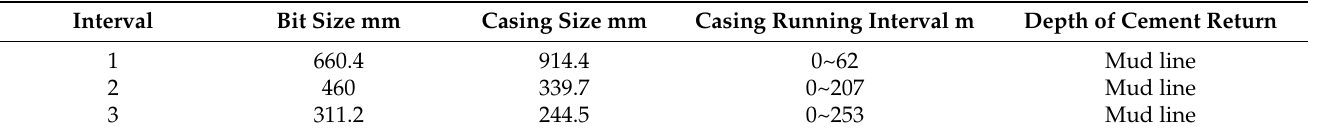
Table 1. Calculation of well structure using the foam cycle purge